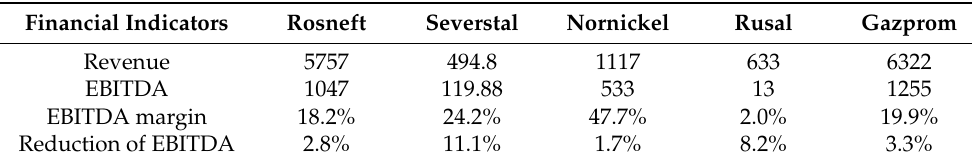
Table 4. Financial indicators, billion